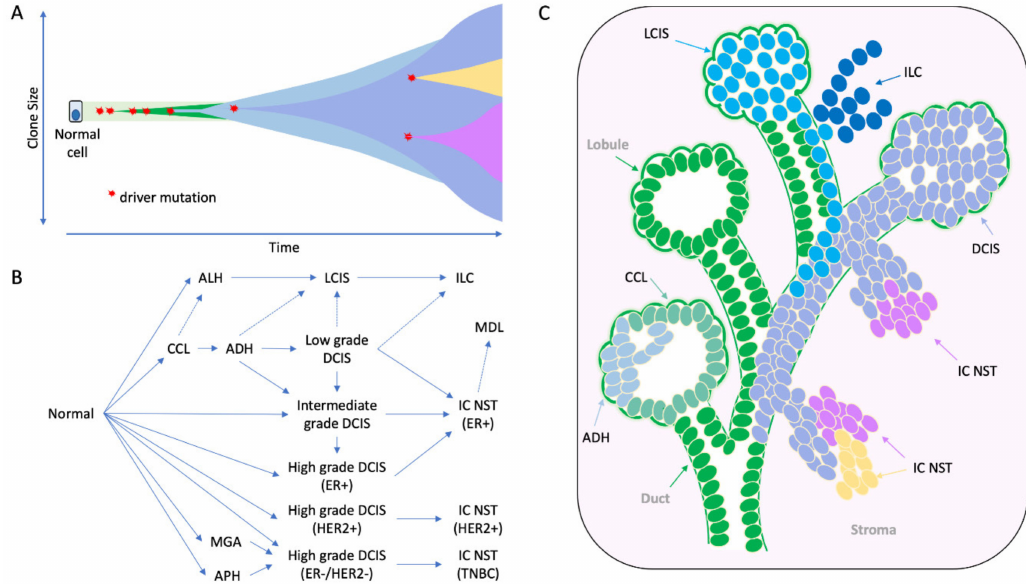
Figure 2. The morphological and molecular evolution of breast cancer. ( A ) Hypothetical schematic showing how the mutation of cancer genes drives the clonal and subclonal evolution of cancer (adapted from [55]). Key early driver genes impact the subsequent lineage and tumour type that arises, including mutations in PI3KCA in ER + tumours, CDH1 in lobular lineage, TP53 in high grade ER- tumours, ETV6-NTRK3 and MYB-NFIB translocations in secretory and adenoid cystic carcinomas respectively. ( B ) the multistep model of breast cancer showing morphological stages of development from normal epithelium. This simplified model is based on the evolution of ER positive and ER negative breast cancer, as portrayed in more detail elsewhere [49–51]; evidence derived from morphological evaluation and the frequency with which lesions are co-localized, as well as molecular evidence showing co-localized lesions share identical mutations indicating clonal relatedness. ( C ) Cartoon to illustrate how this might arise in a ‘sick lobe’, that is a clonal outgrowth of apparently morphologically normal-looking epithelial cells (green), which harbour early genetic changes. In some areas of the lobe, the earliest morphologically abnormal changes may appear in some terminal duct-lobular units (lobule) as columnar cell lesions. These lesions are considered precursors of ADH (light blue cells) and DCIS (purple cells), which arise in lobules and may travel down ducts. The mutation or loss of CDH1 (E-cadherin) triggers the evolution of the ’lobular lineage’ (sky blue cells) as ALH then LCIS (lobular neoplasia); these cells may travel down ducts underneath the normal epithelial lining (pageotoid spread). Both LCIS and DCIS are genetically advanced lesions and so likely exhibit sub-clonal mutations. As these neoplastic cells can travel along ductal structures then this means invasion can occur at multiple sites giving rise to multifocal invasive disease (ILC, IC NST), which continues to undergo subclonal change. CCL: columnar cell lesion; ADH: atypical ductal hyperplasia. ALH: atypical lobular hyperplasia, APH: atypical apocrine hyperplasia; DCIS: ductal carcinoma in situ; LCIS: lobular carcinoma in situ; IC NST: invasive carcinoma no special type; ILC: invasive lobular carcinoma; MDL: mixed ductal lobular carcinoma; MGA: microglandular